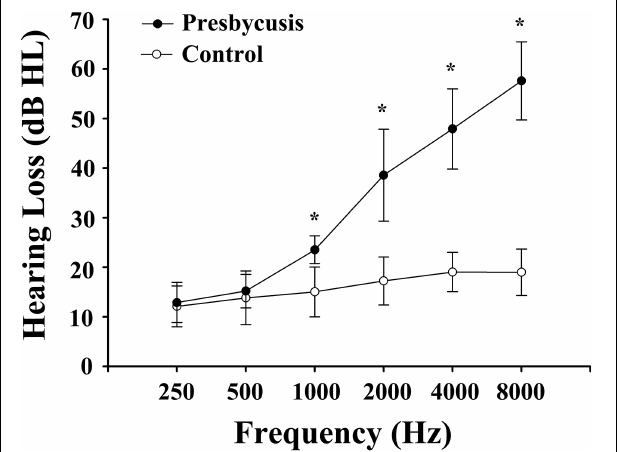
TABLE 2 | Neuropsychological scores of patients with presbycusis and HCs. Patients with presbycusis ( n = 51)